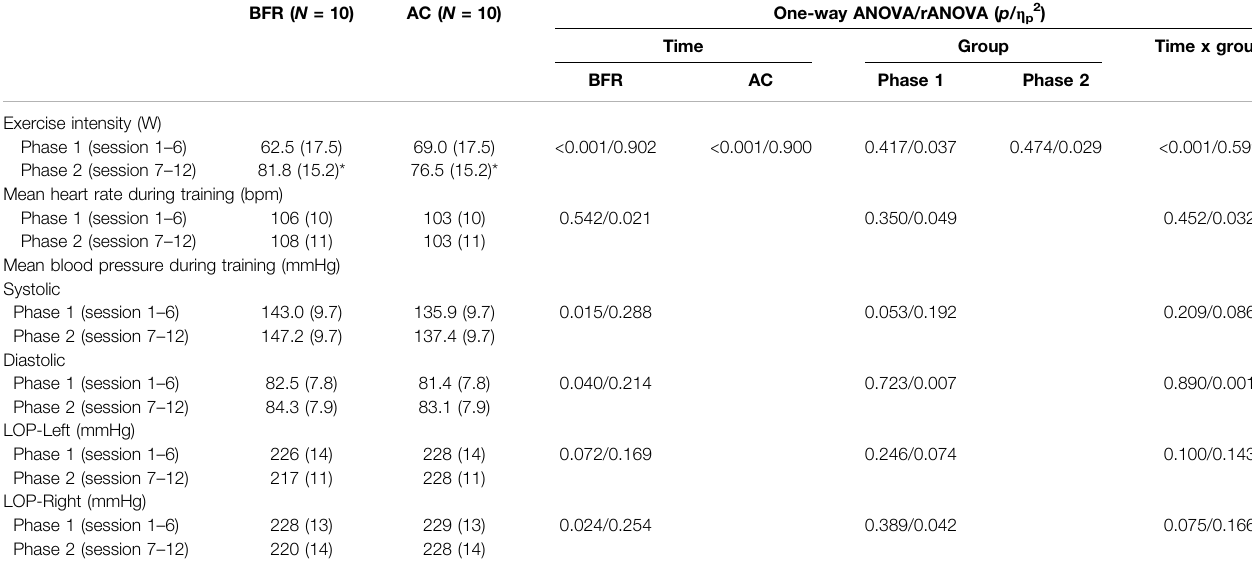
TABLE 2 | Measures related to training during the 6-weeks prehabilitation period of both training groups. BFR ( N =